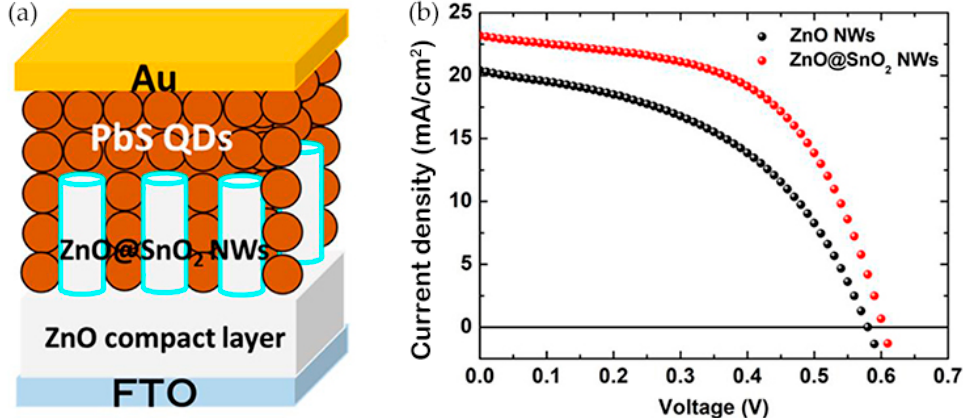
Figure 4. ( a ) Structural illustration of ZnO NW ‐ based CQDSCs with SnO 2 passivation layers; ( b ) the J ‐ V characteristics of ZnO NW CQDSCs with or without SnO 2 passivation [92].